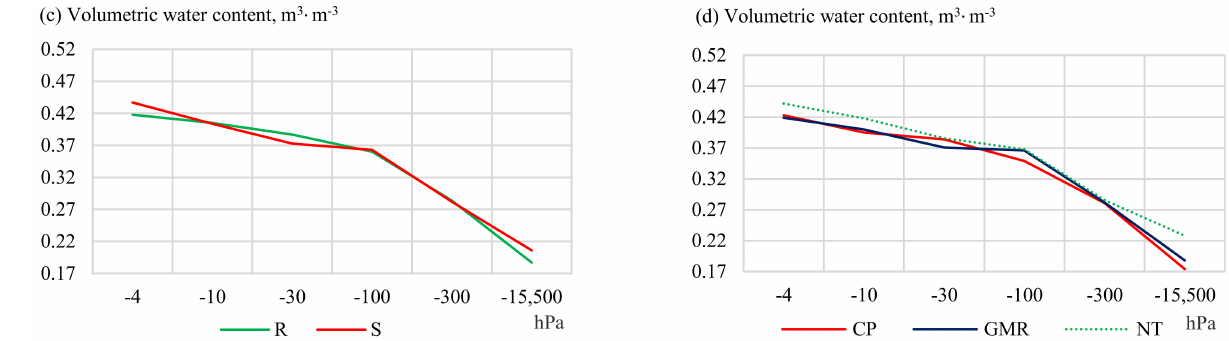
Figure 3. Soil water retention capacity at a depth of 15–20 cm in ( a , b ) 2013 and ( c , d ) 2019. Notes: No significant differences at p > 0.05; Fisher LSD test vs. control. Other explanations are given in Table 1.